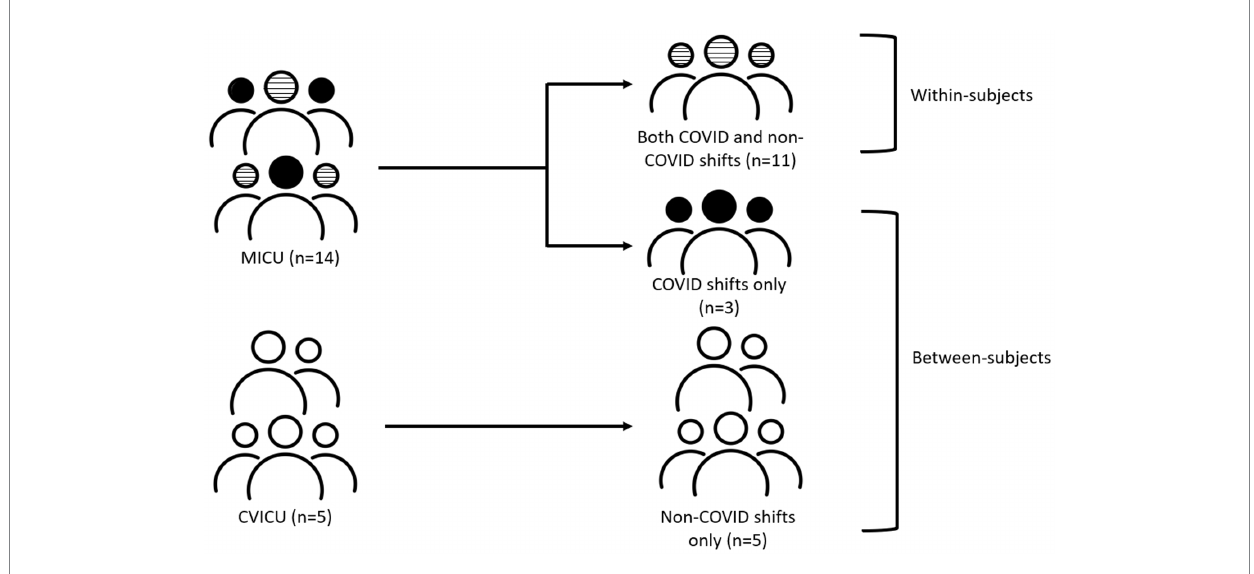
FIGURE 1 Statistical study design to compare stress levels in